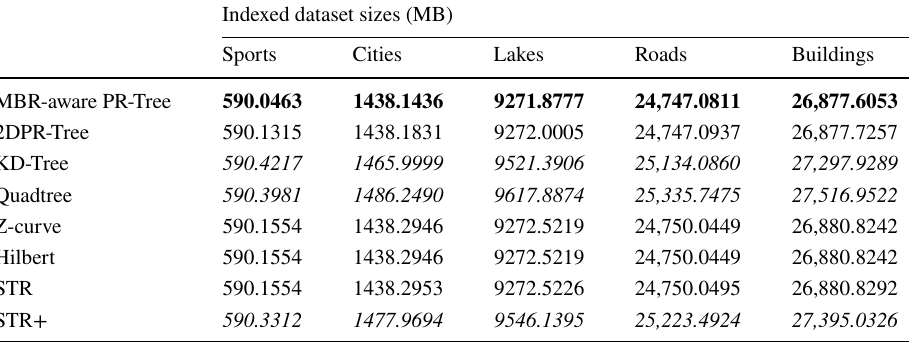
Fig. 10 Indexing time for the real datasets (Sports, Cities, Lakes, Roads, and